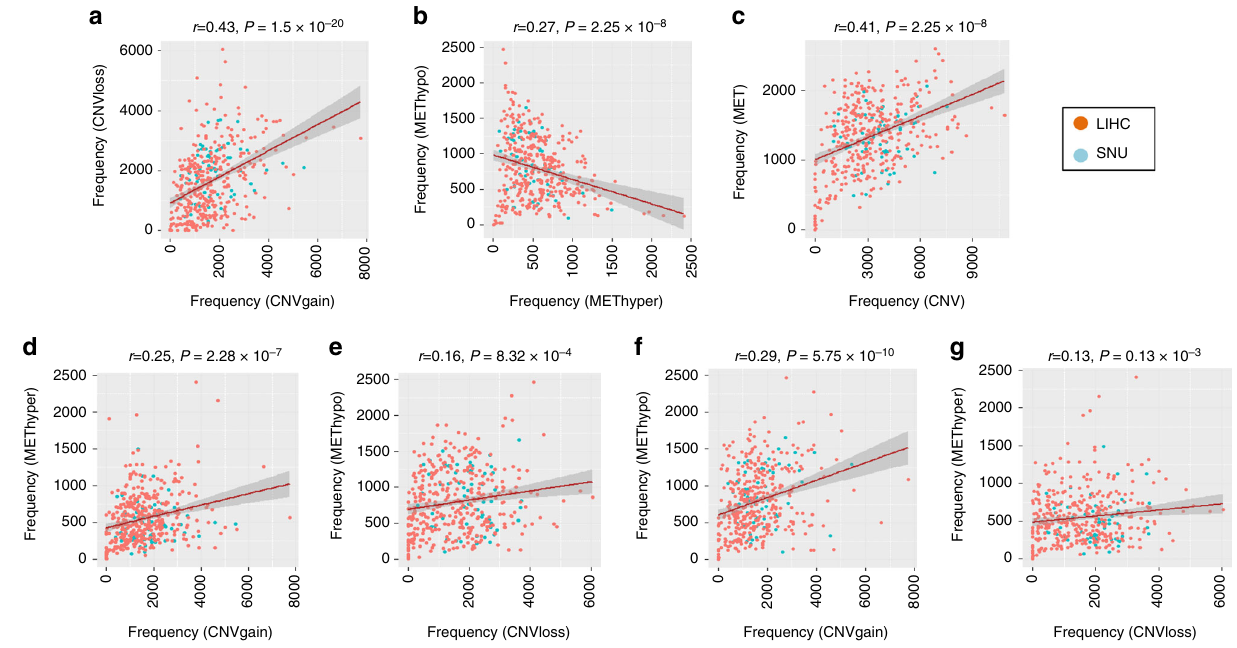
Fig. 4 Coordinated aberrations of DNA copy number and DNA methylation in liver cancer. a , b The SNU and LIHC data sets of DNA copy numbers or DNA methylation are integrated by applying “ combat ” method as described in “ Methods. ” Aberrations of DNA copy numbers or DNA methylation were determined with cutoff fold difference > 0.2 compared to those of the average values of the non-tumoral tissues, respectively. Directional alterations of DNA copy-number gain (CNVgain) and loss (CNVloss) and DNA hypermethylation (METhyper) and hypomethylation (METhypo) in each sample are plotted, respectively. c Overall frequencies of CNV aberration including CNVgain and CNVloss and DNA methylation including METhyper and METhypo are plotted. d – g Plots show the pairwise frequencies of CNVgain, CNVloss, METhyper, and METhypo genes in individual